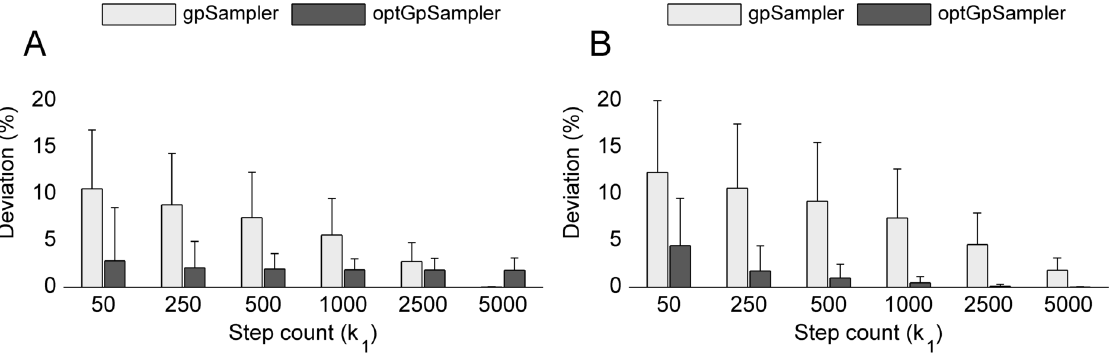
Figure 4. xy -deviation for C. thermocellum iSR432. xy -deviation from samples obtained with sampler x at step count k 1 to sampler y using k 2 =5000. (a) Deviation to samples obtained by y = gpSampler . (b) Deviation from samples obtained by y = optGpSampler . In both cases optGpSampler converges much faster to sampler y .